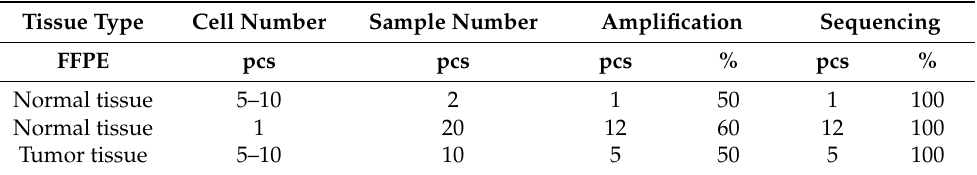
Table 4. Summary of the success rate of amplification and sequencing of the analyzed BRCA2 genomic region from FFPE samples.